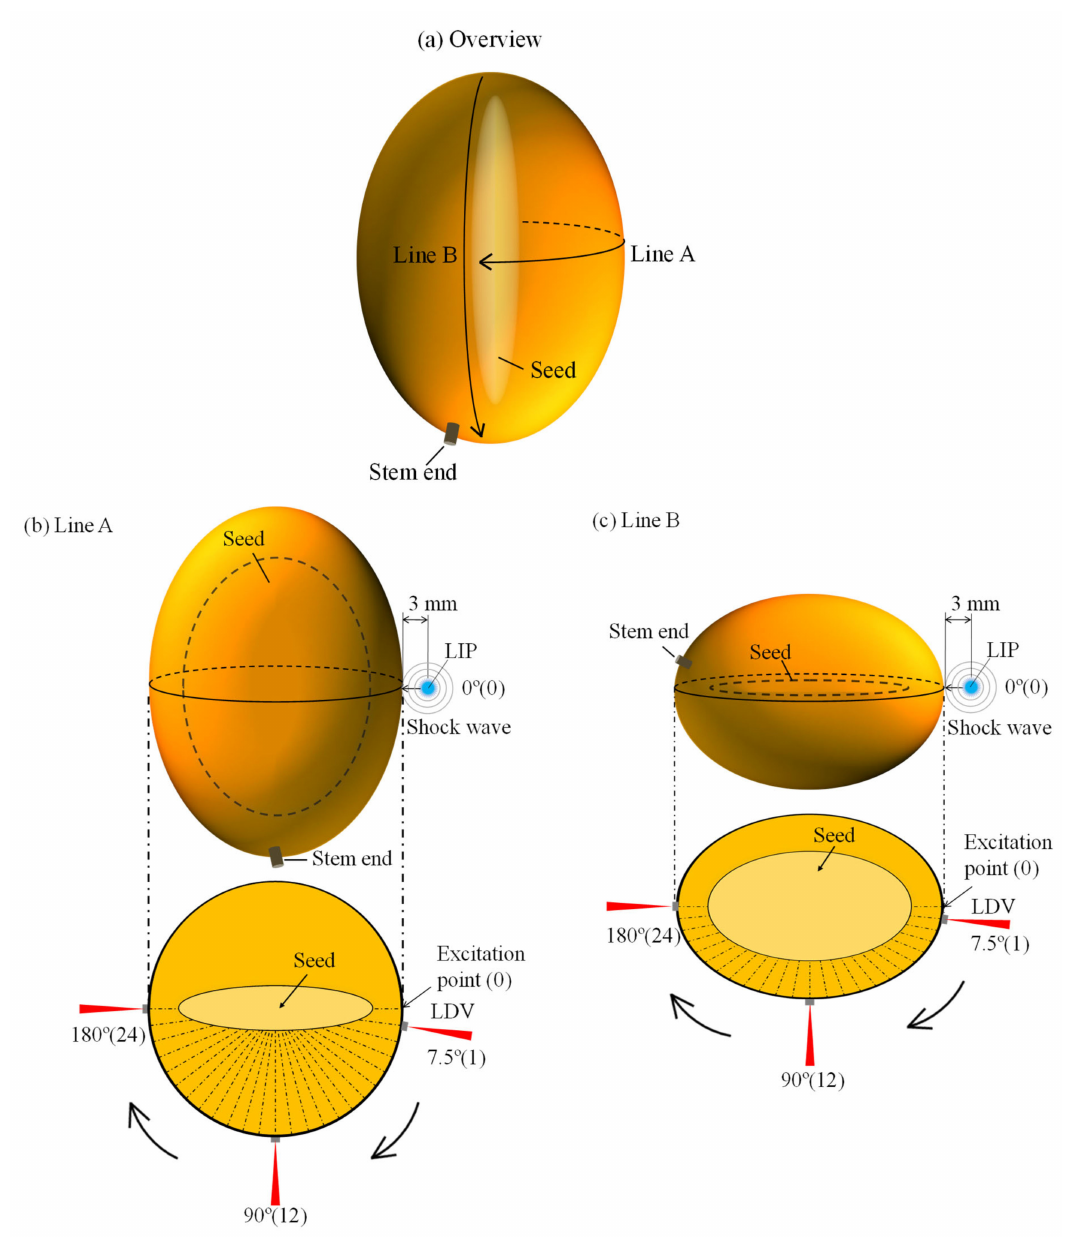
Figure 2. Measurement paths of the Rayleigh wave on a mango. ( a ) Overview of a mango. ( b ) Line A represents the measurement points on the equator. ( c ) Line B represents the measurement points orthogonal to the